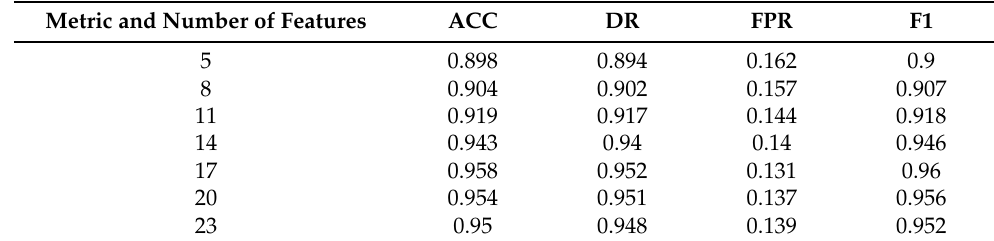
Table 3. The experimental evaluation results for the proposed LR-IDS in terms of accuracy, detection rate, false positive rate, and F measure.